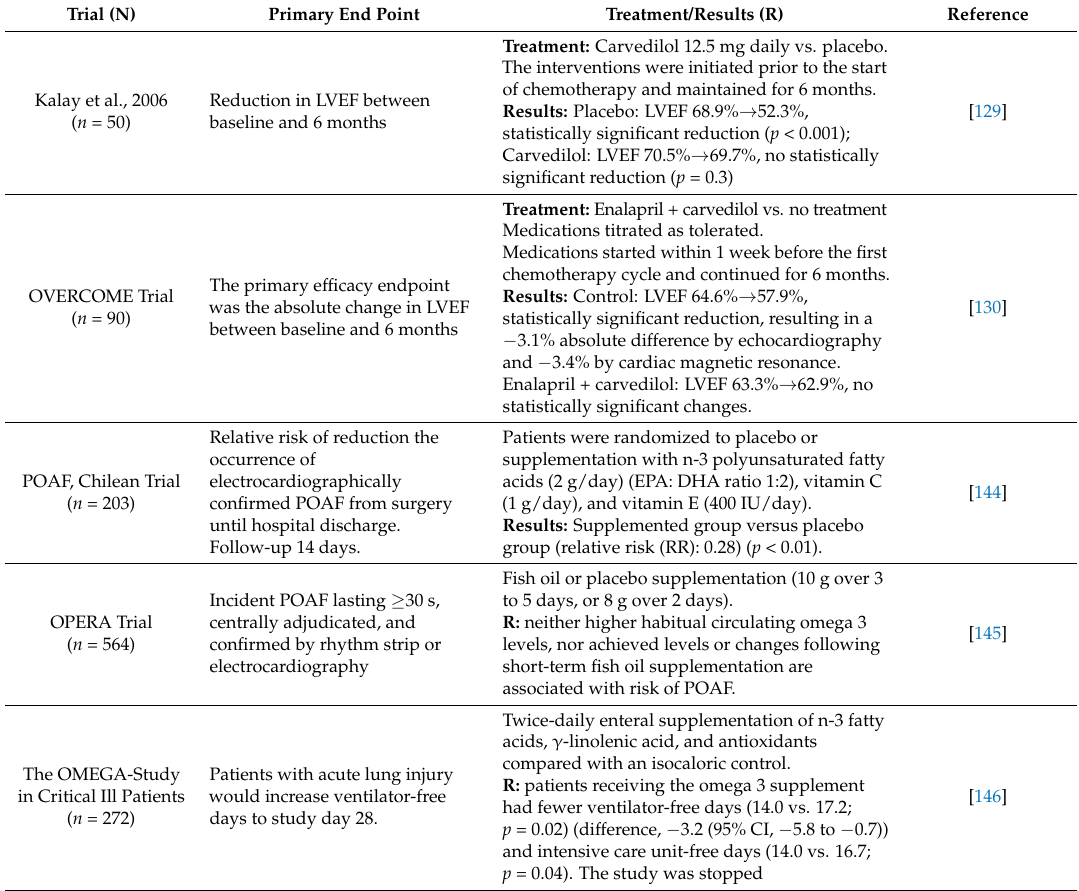
Table 1. More important clinical trials with antioxidant therapies in cardiovascular pathologies related with oxidative